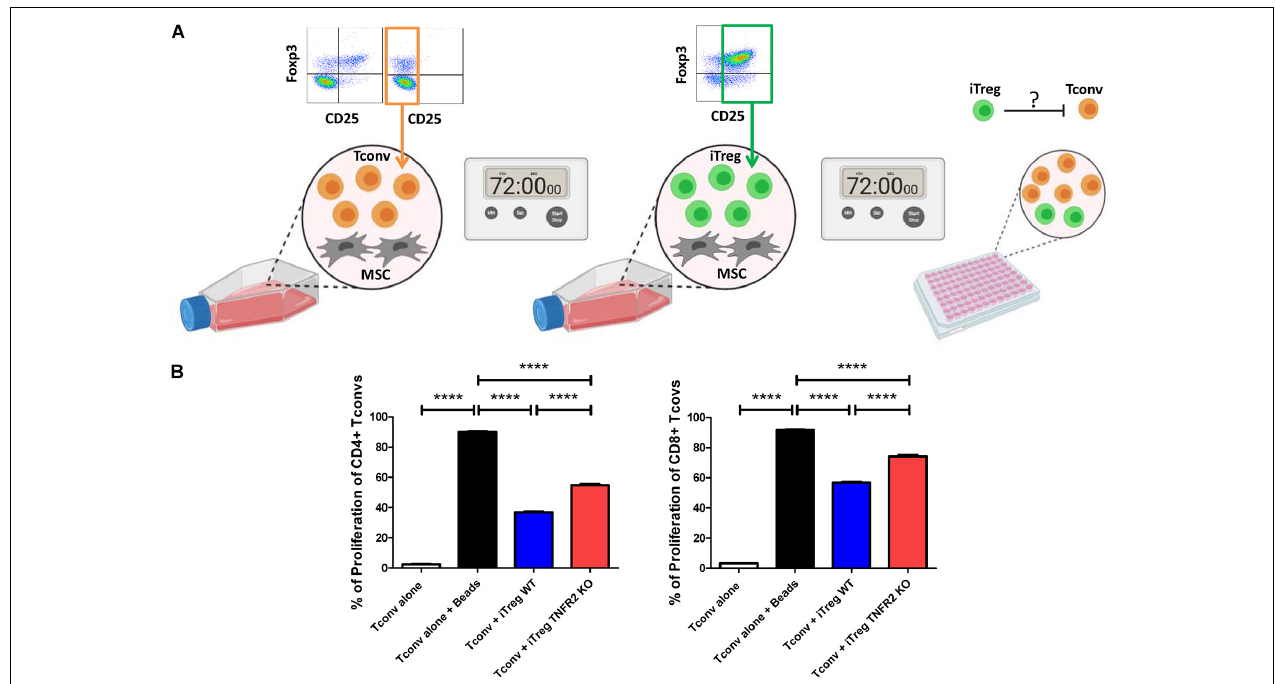
FIGURE 5 | The TNFR2 Expression by mesenchymal stem cells (MSCs) is associated with the induction of Tregs with more immunosuppressive effect. (A) T cells were freshly isolated and depleted from CD25 subpopulation in order to eliminate natural Tregs and highly activated T cells. CD3 + CD25 − Tconvs (orange population) were then added to wild-type (WT) and TNFR2 knockout (KO)-MSCs in a fixed 1/10 MSC/T cell ratio. After 72 h, CD4 + CD25 + Foxp3 + induced regulatory T cells (iTregs) generated in those co-cultures (green population) were put in an mixed lymphocyte reaction (MLR) test with newly isolated and activated mouse CFSE + CD3 + CD25 − Tconvs in a fixed 1/5 iTreg/Tconv ratio. Then, the CD4 + and CD8 + proliferation capacity was measured by fluorescence-activated cell sorting (FACS). (B) Percentage of proliferation of CD4 + and CD8 + Tconvs in the presence of MSC induced Foxp3 + Tregs. Control groups consist of unstimulated T cells alone as depicted by the white columns ( n = 6), while the stimulated T cells alone are depicted by the black columns ( n = 6). The blue columns represent the stimulated T cells co-cultured with iTregs derived from WT-MSCs ( n = 6), and the red columns represent the stimulated T cells co-cultured with iTregs derived from TNFR2 KO-MSCs ( n = 6). Results are collected from two independent experiments. The graphical images were created with